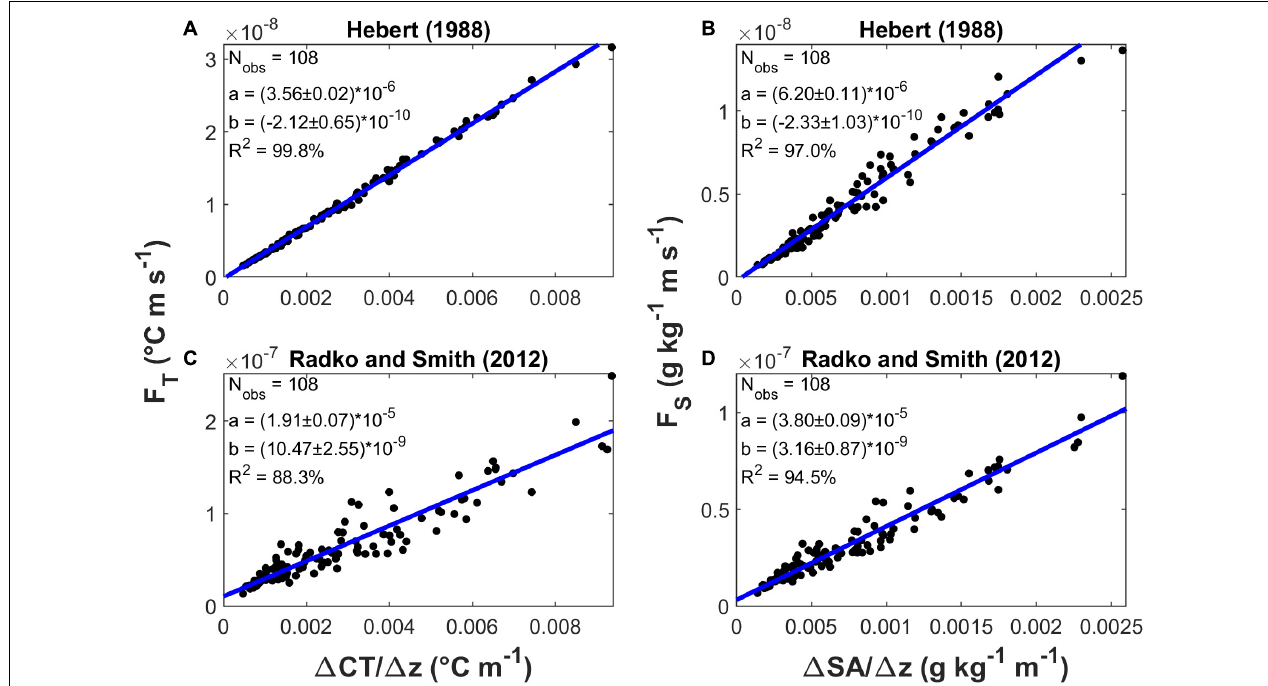
FIGURE 10 | Fluxes versus gradients. (A) Heat flux F T ( ◦ C m s − 1 ) versus CT gradient ( ◦ C m − 1 ), with H88. (B) Salinity flux F S (g kg − 1 m s − 1 ) versus SA gradient (g kg − 1 m s − 1 ), with H88. (C) Heat flux F T ( ◦ C m s − 1 ) versus CT gradient ( ◦ C m − 1 ), with RS12. (D) Salinity flux F S (g kg − 1 m s − 1 ) versus SA gradient (g kg − 1 m s − 1 ), with RS12. Each panel includes the slope (a) and the intercept (b) of a linear fit (Matlab function fitlm) to presented data, accompanied by their standard errors; a value for R 2 is also reported.